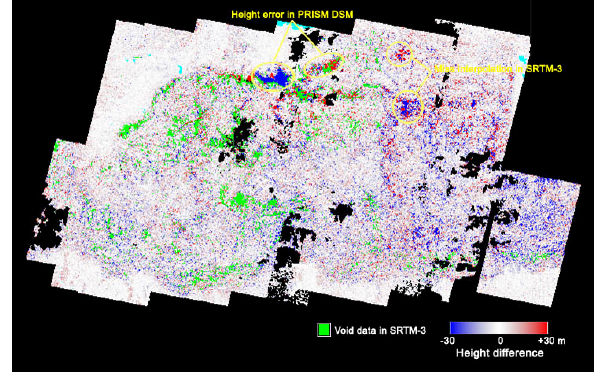
Figure 11. Height difference image of PRISM DSM minus SRTM-3 in Bhutan. The black colors show the masked areas in the PRISM DSM, while the green colors represent the void data areas in SRTM-3.